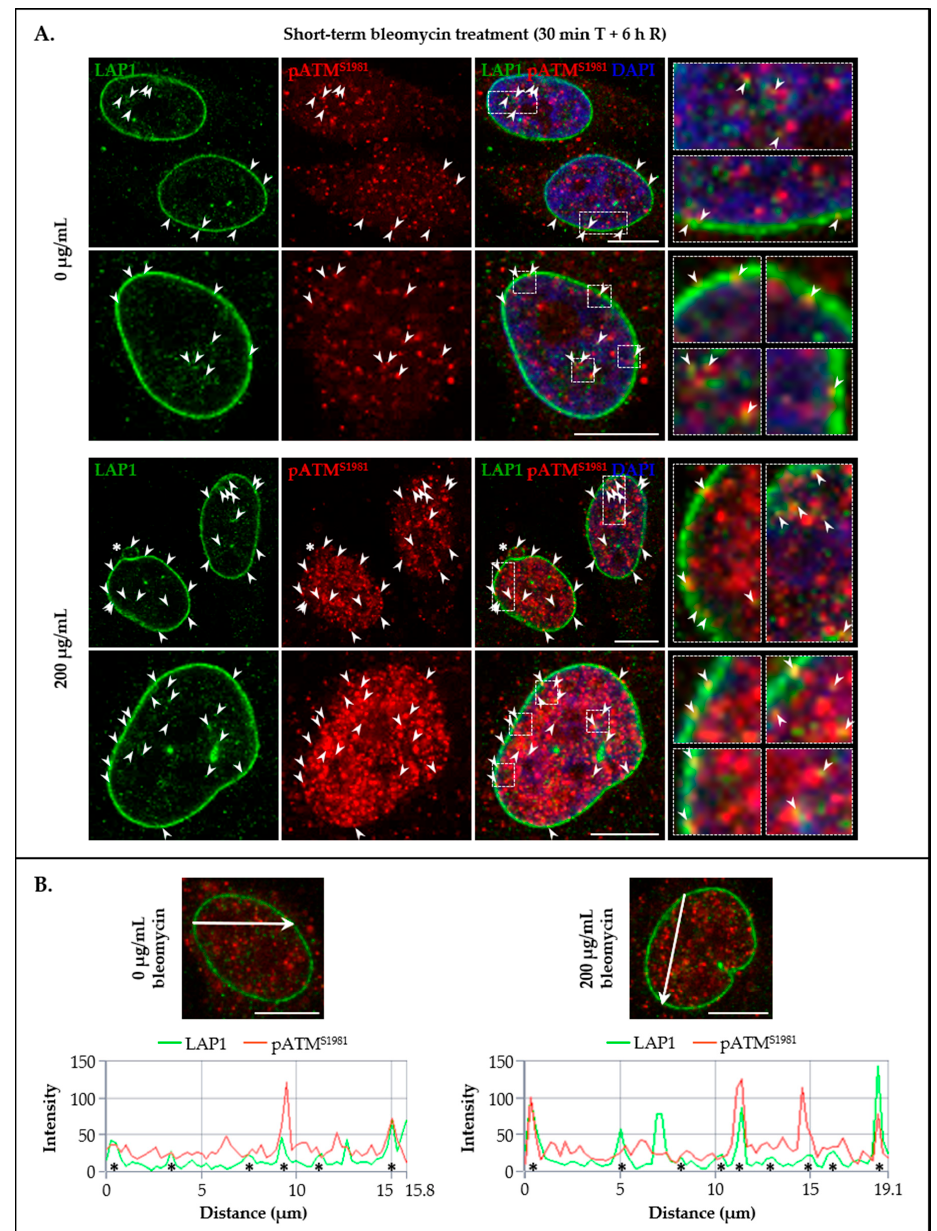
Figure 9. Analysis of the subcellular co-distribution of LAP1 and pATM S1981 in the human HeLa cell line. ( A ) Immunolocalization of LAP1 (green) and pATM S1981 (red) in control conditions and after DNA damage induction through cell exposure to 200 µg/mL of bleomycin for 30 min (T), followed by 6 h of recovery (R). Upon fixation, HeLa cells were immunostained with LAP1- and pATM S1981